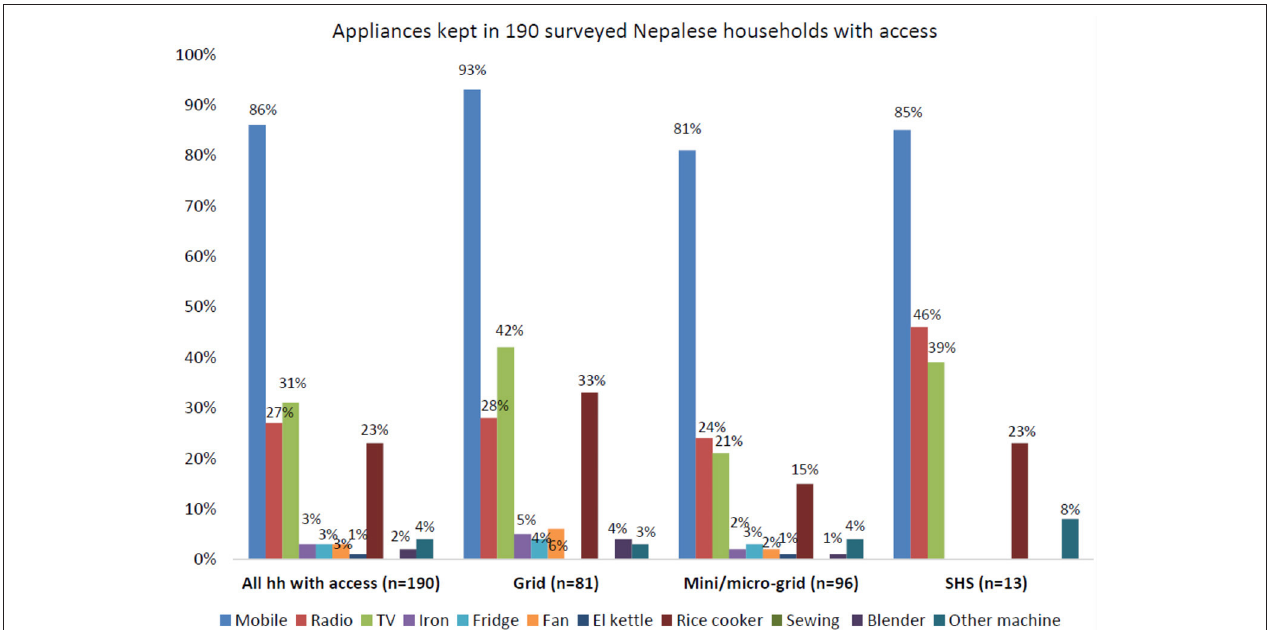
FIGURE 2 | Appliances kept in 190 surveyed households with access. HH: Households; SHS: Solar Home